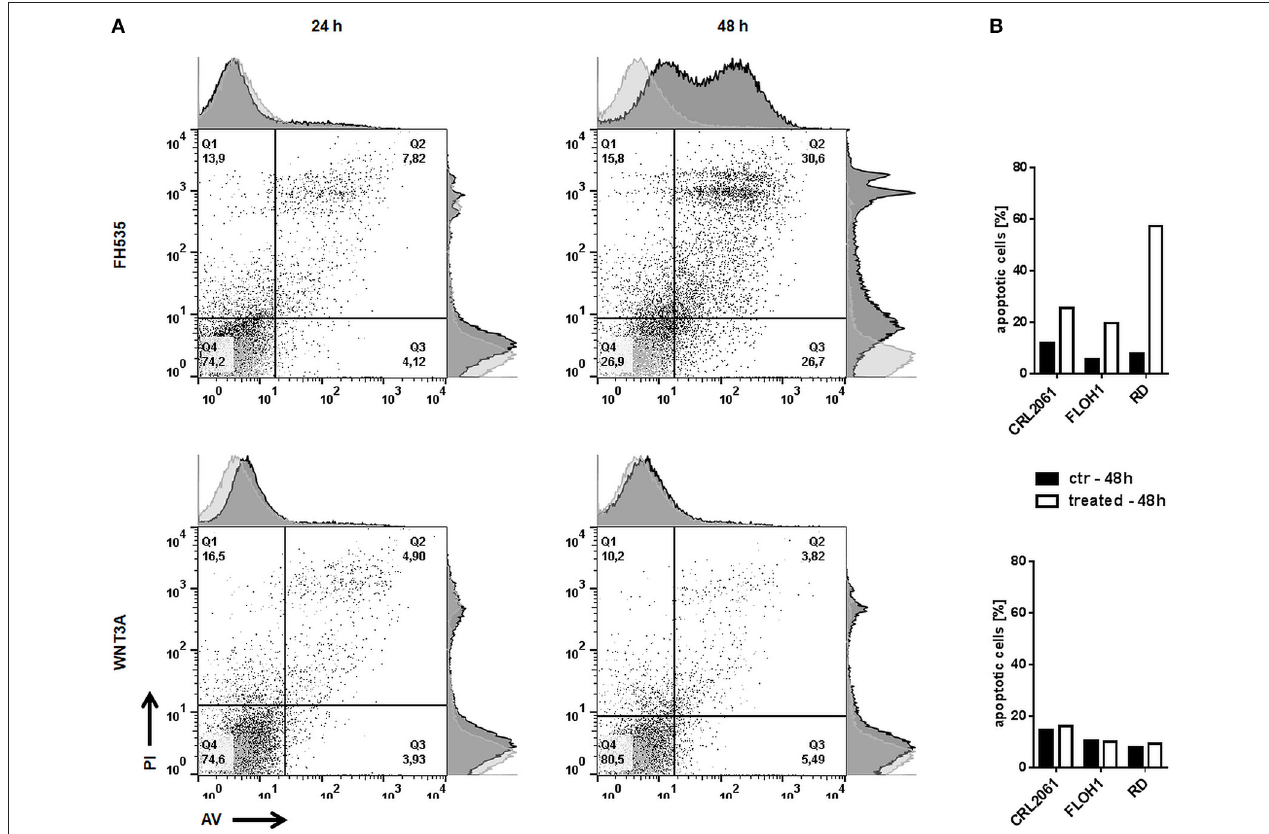
FIGURE 6 | Effects of FH535 and WNT3A on apoptosis of RMS cell lines. (A) Flow cytometry analysis of Annexin V/PI positive RD tumor cells 24 and 48h after treatment with FH535 (upper panel) or WNT3A (lower panel). An additional histogram plot on the Annexin V- (x-) axis and PI- (y-) axis illustrates the shift of apoptotic cells (dark gray) compared to untreated control cells (light gray). (B) represents a graphic summary of the apoptotic cells of all three cell lines in percent after 48h of treatment.